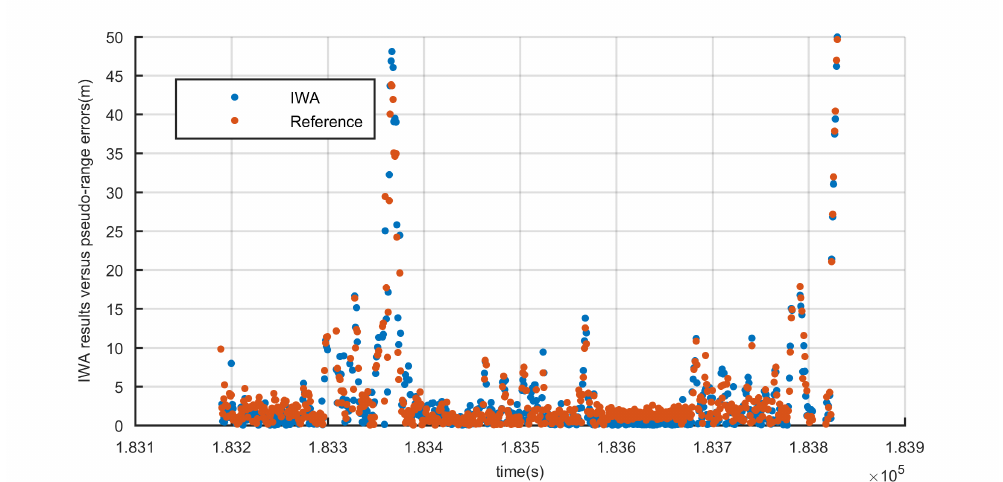
Figure 8. IWA results versus true pseudo-range errors.